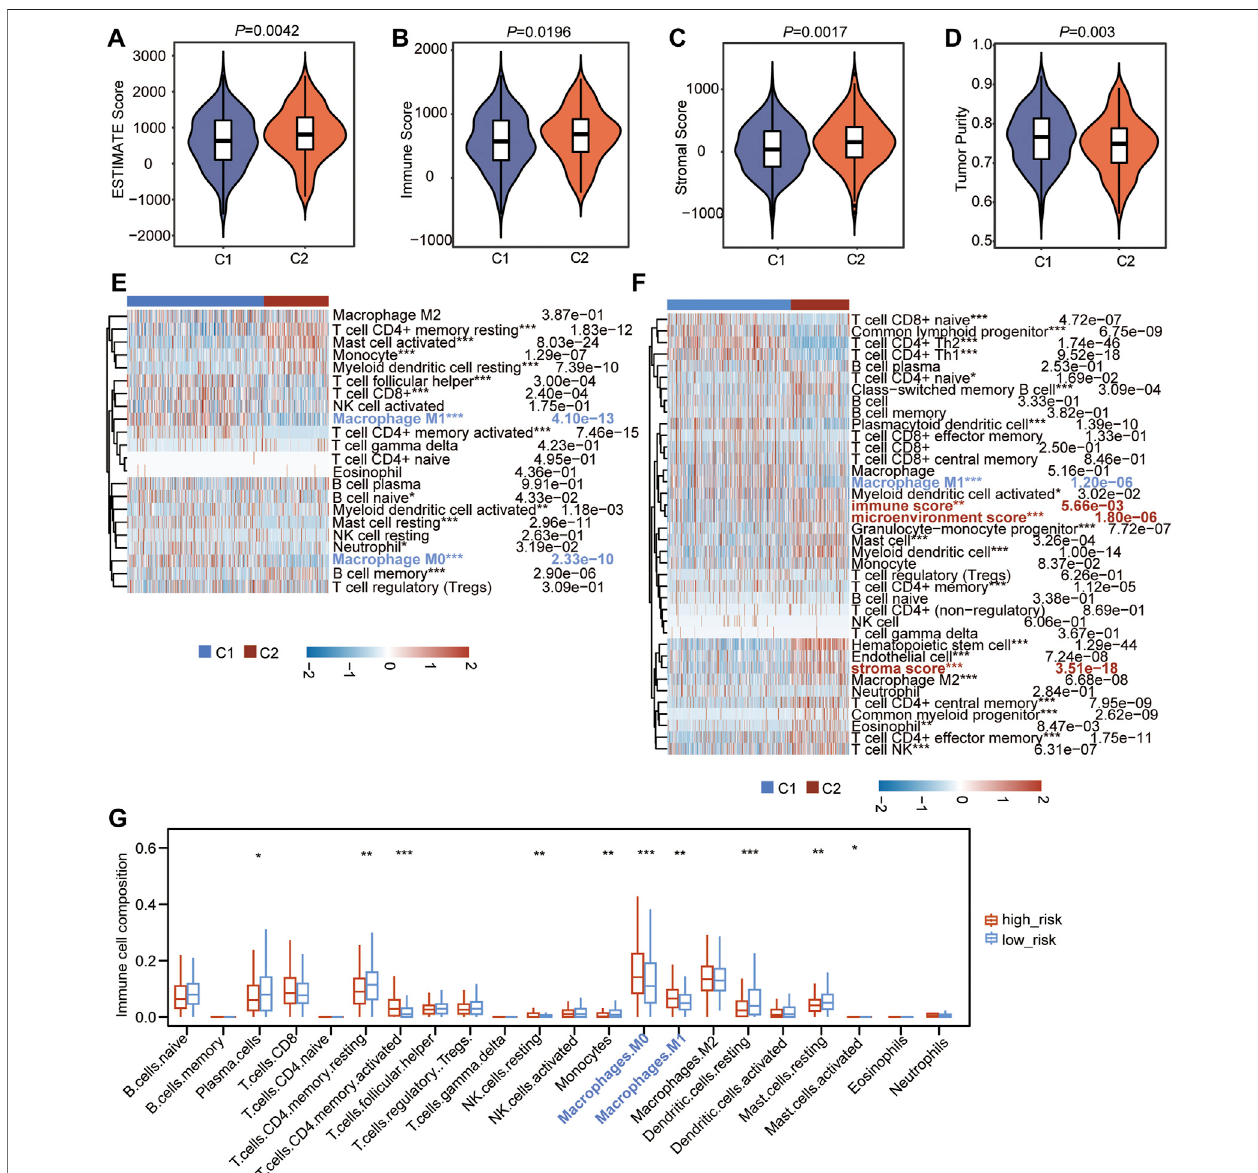
FIGURE9| CSRs are associated withimmunecharacteristics ofLUAD. (A – D) Comparison ofestimate score (A) , immune score (B) ,stromal score (C) , and tumor purity (D) in the two clusters. (E) Heatmap showing the 22 types of immune cells in fi ltration in the two clusters by CIBERSORT algorithm. (F ) Heatmap showing the 27 types of immune cells in fi ltration in the two clusters by xCell algorithm. The red label represents the cells that were highly in fi ltrated in cluster 2, the blue label represents the cells that were highly in fi ltrated in cluster 1. The statistical signi fi cance was calculated via Wilcoxon rank-sum test, *** p < 0.001, ** p < 0.01, * p < 0.05. (G) The differenceinin fi ltratedabundanceofimmunecellsbetweenthetworiskgroups.Thein fi ltratedabundanceofimmunecellswascalculatedbyCIBERSORTalgorithm.The statistical signi fi cance was calculated via Wilcoxon rank-sum test, *** p < 0.001, ** p < 0.01, * p <